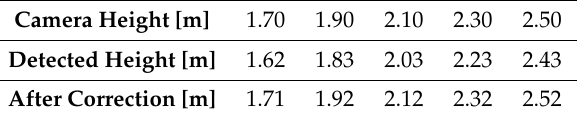
Table 3. Experimental results from camera-height detection.